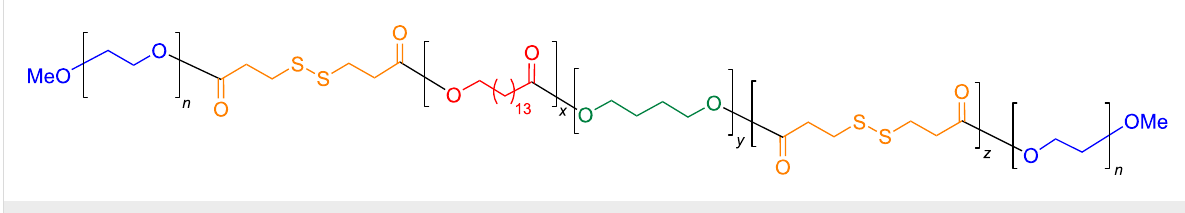
Figure 8: Polyesters containing disulfide moieties.